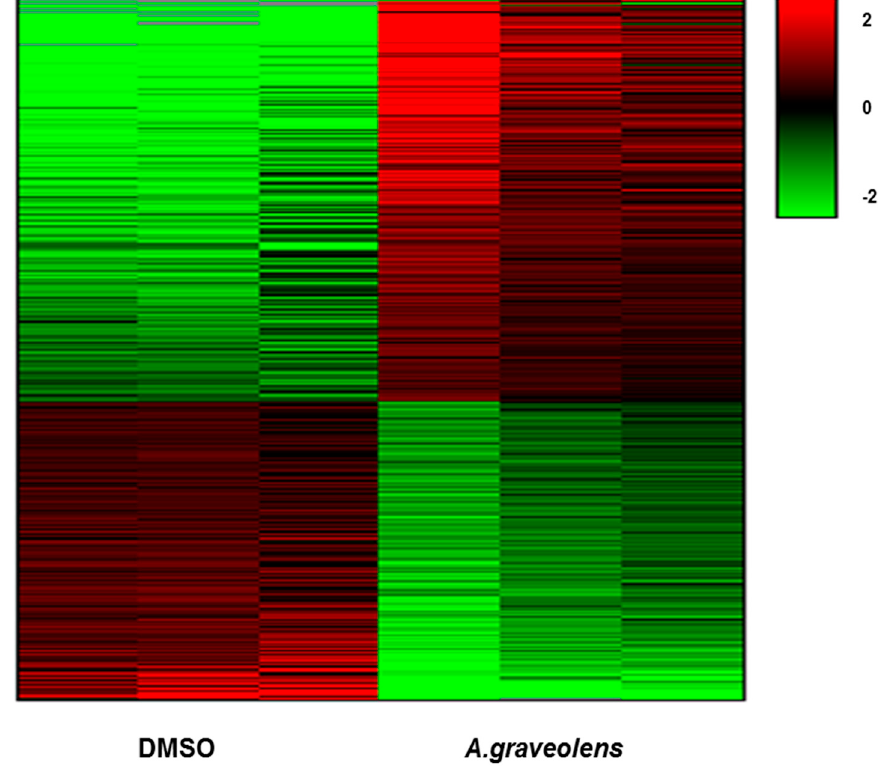
Figure 5. Differential gene expression in BS-24-1 cells pre-and post A. graveolens extract treatment. Hierarchical clustering analysis (Heat Map) of up- and down-regulated genes in BS-24-1 cells following treatment with A. graveolens ethyl acetate extract was performed. Red indicates up-regulated genes while green indicates down-regulated genes.